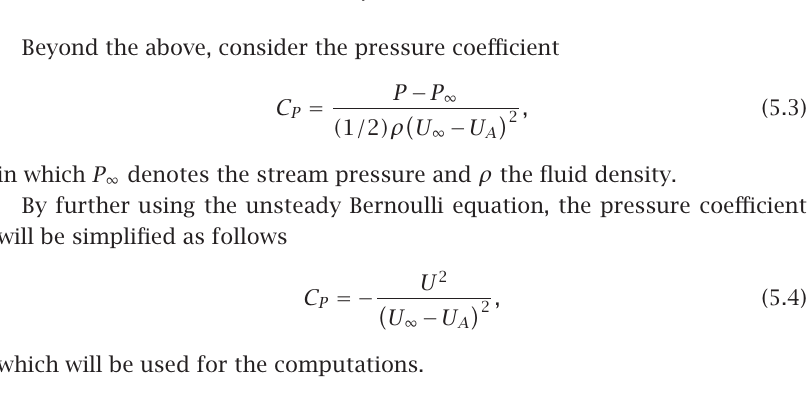
Figure 5.1 . Coordinate system for 2D airfoil of an